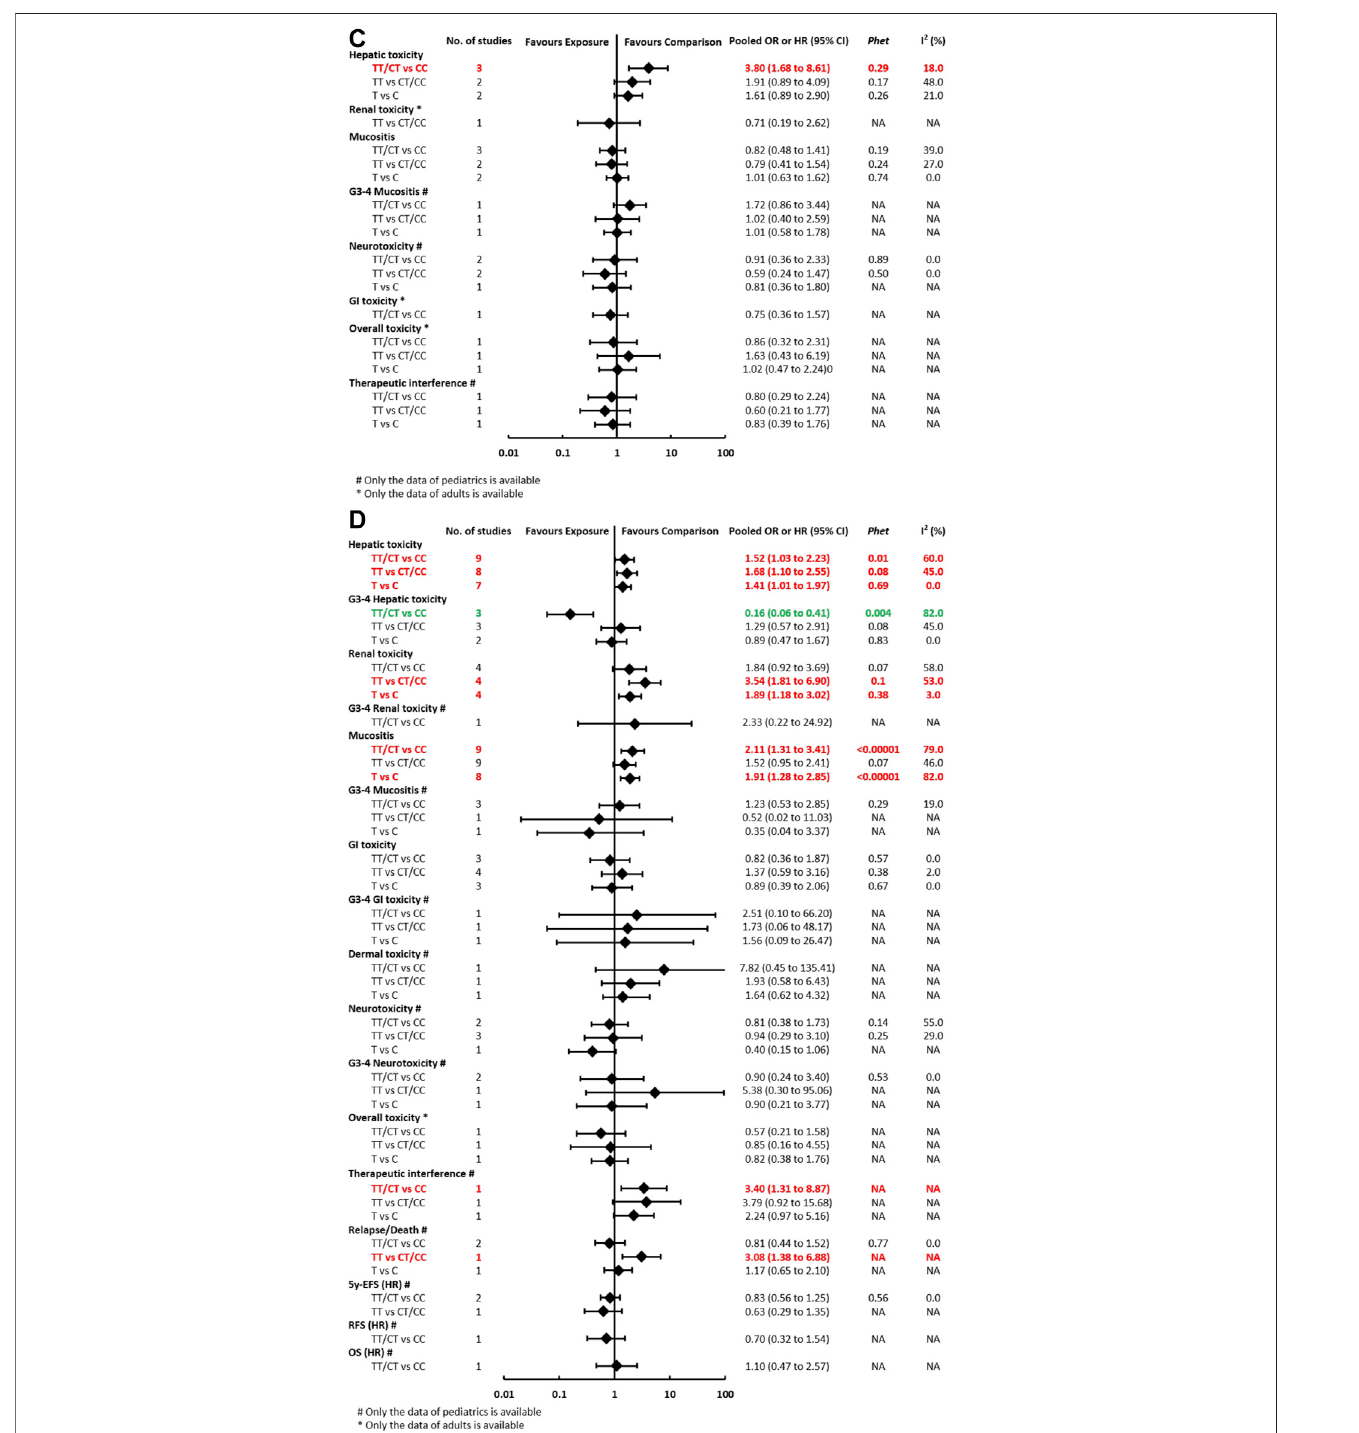
FIGURE 3C-D | (C) Findings of the association between ABCB1 (rs1045642) and HDMTX-related outcomes under three genetic models. (D) Findings of the association between MTHFR (rs1801133) and HDMTX-related outcomes under three genetic models.